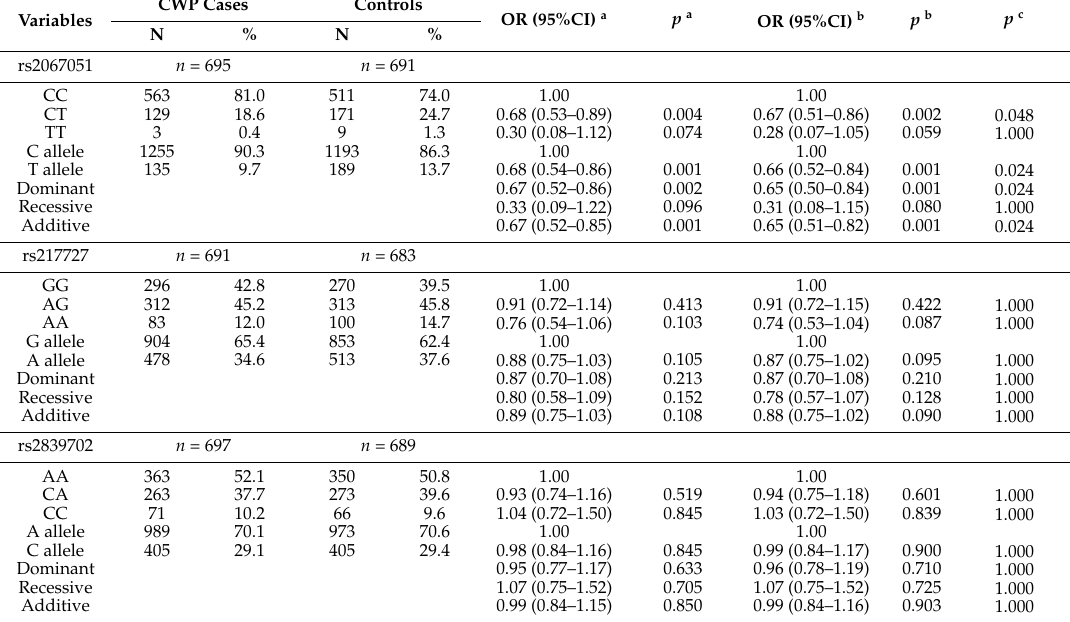
Table 3. Distributions of genotypes of H19 and their associations with the risk of coal workers’ pneumoconiosis